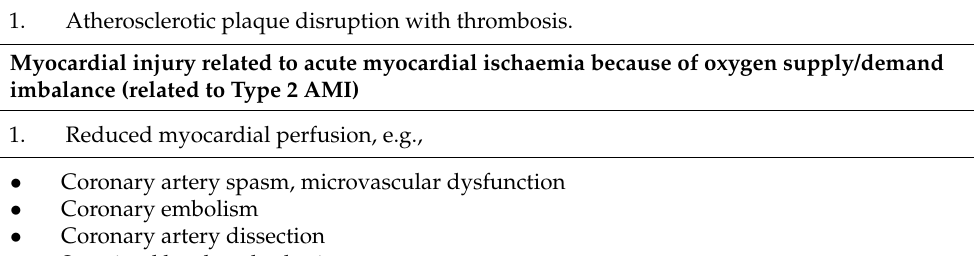
Table 2. Pathophysiological conditions associated to elevation of measured circulating levels using hs-cTnI and hs-cTnT methods due to the presence of myocardial injury, according to the Fourth Universal Definition of Myocardial Infarction